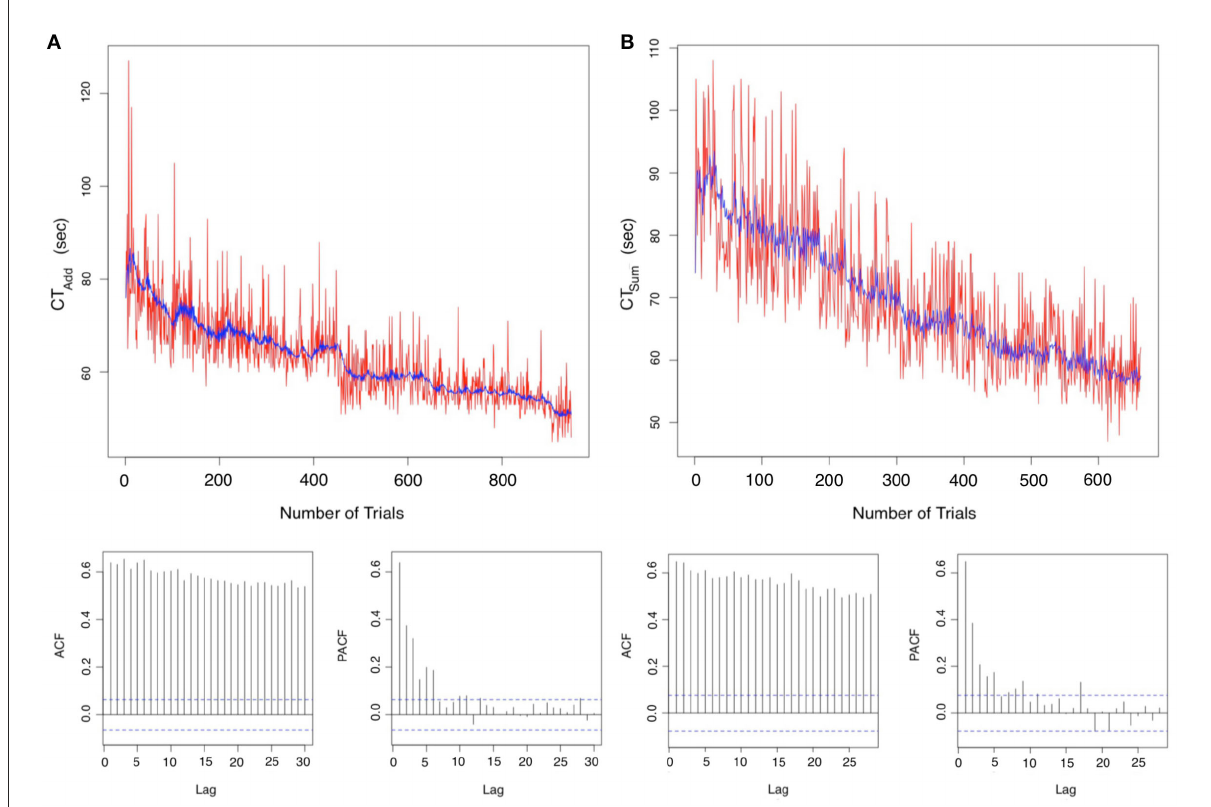
FIGURE3 Analysis in the time domain for the initial period data: Autoregressive integrated moving average (ARIMA) model for the (A) Addition task time Series ARIMA (2,1,3) with Drift (B) Summation time series plot ARIMA (4,1,3) with Drift. Autocorrelation defines the degree of similarity between a particular time series and a lagged version of itself over subsequent time intervals. The autocorrelation functions (ACF) demonstrate a declining geometric pattern consistent with the trend of the time series of accelerating response time, which remain significant at the 95% confidence interval for a lag > 25. Partial autocorrelation functions (PACF) show that lags < 6 and < 5 are significant for addition and summation, respectively. Consequently, confirming an autoregressive model fit below the 5th order for both tasks.